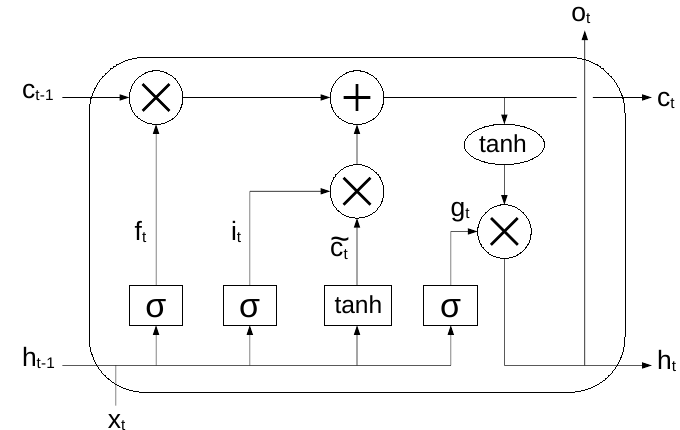
Figure 2. LSTM cell